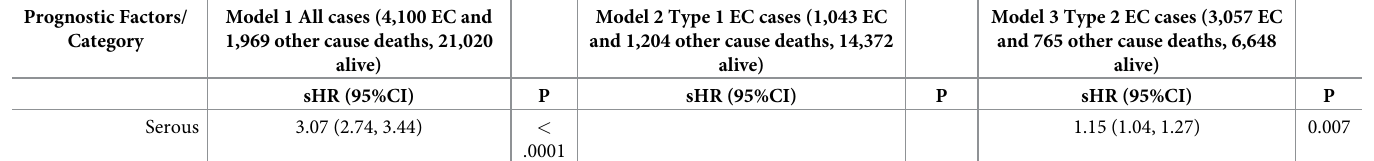
Prognostic Factors/ Category